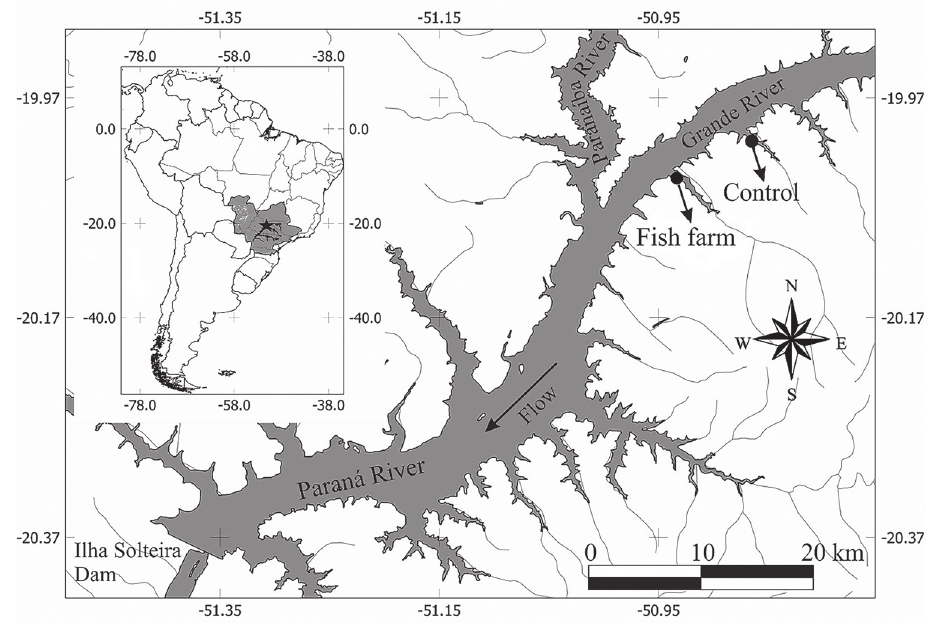
FIGURE 1 | Map of South America showing the Ilha Solteira reservoir, with an indication of the sample areas (black circles). Adapted from Kliemann et al .